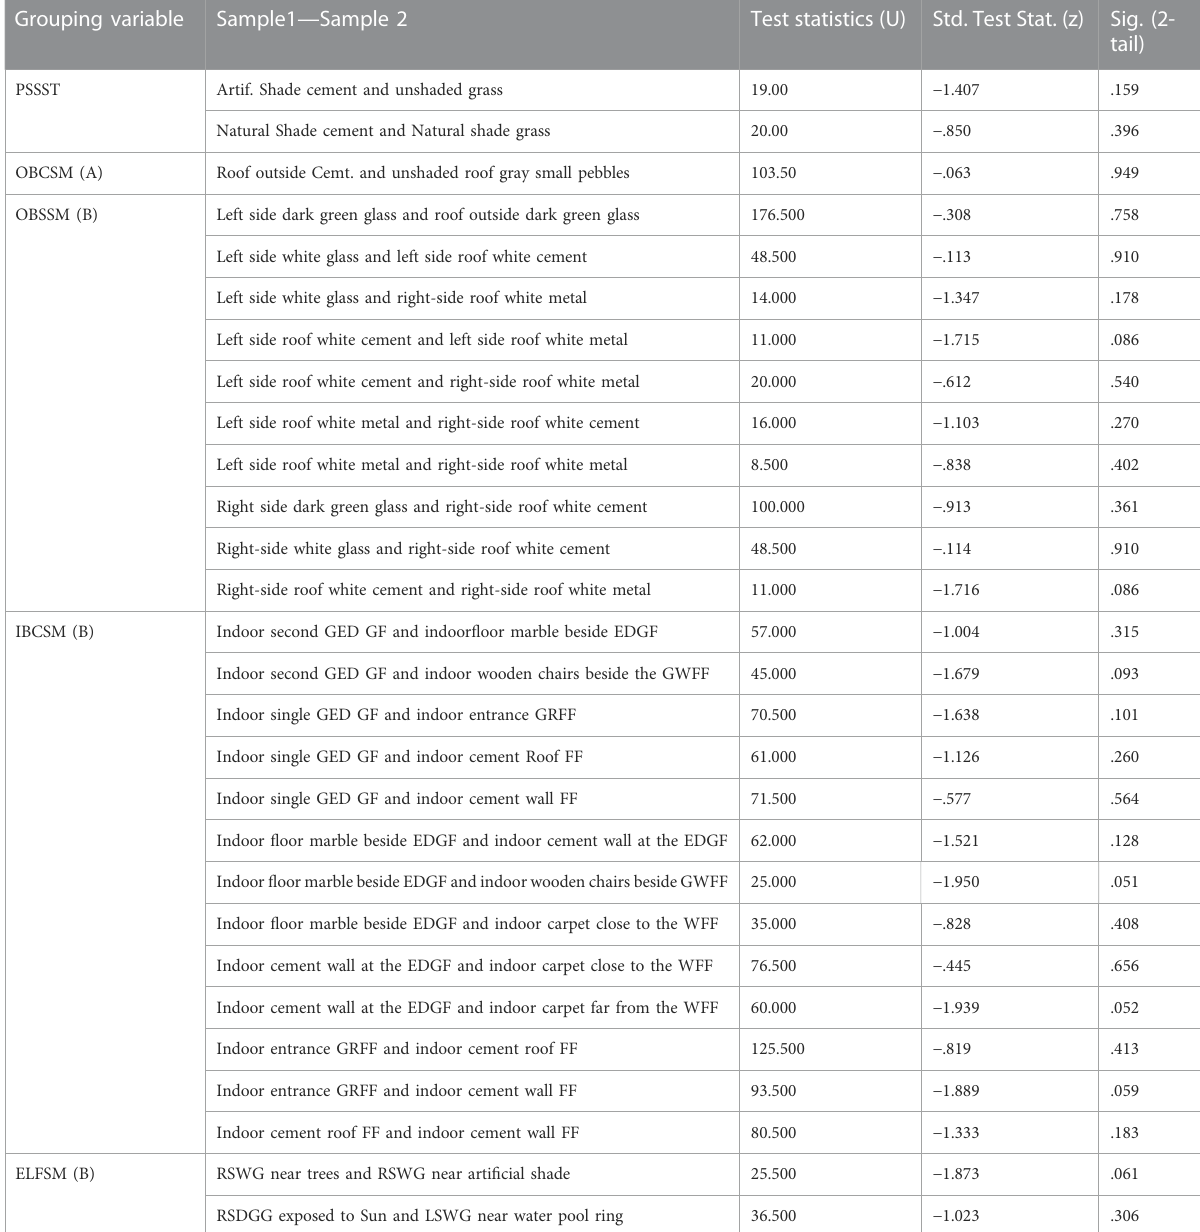
TABLE 6 Pairwise Comparisons of the PSSST, OBCSM (A), OBSSM (B), IBCSM (B), and ELFSM (B) Grouping Variables in terms of Temperature